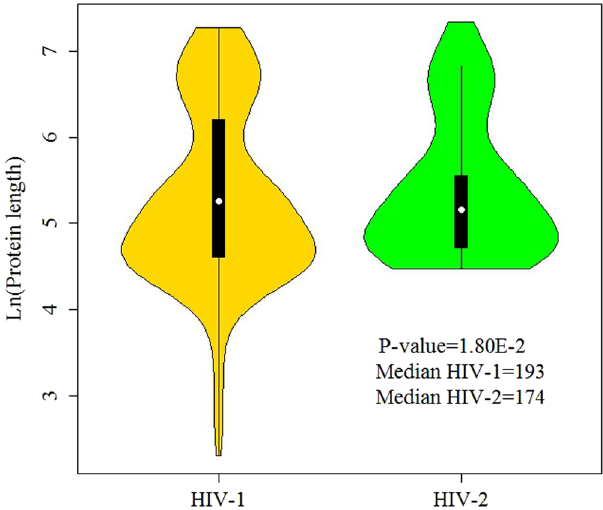
Figure 2. The violin plots for protein lengths of HIV-1 proteins and HIV-2